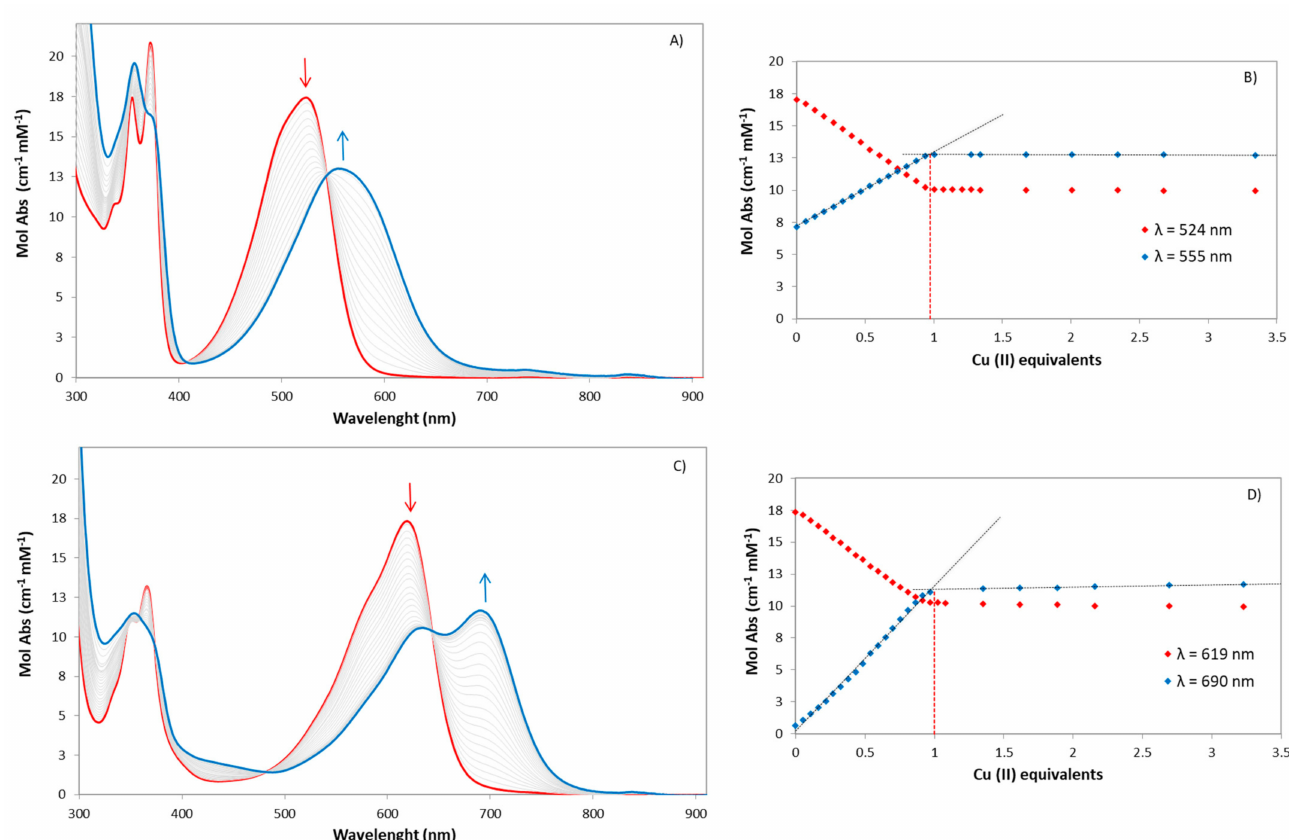
Figure 2. Spectrophotometric titration spectra of 5 µ M ( A ) HP2 and ( C ) PE2 with increasing amounts of Cu(II) in 0.1 M HEPES buffer, pH 7.4, 25 ◦ C, in a cell of 10 cm optical length. Molar absorption profiles at ( B ) 524 (red diamonds) and 555 (blue diamonds) nm for HP2Cu complexation and at ( D ) 619 (red diamonds) and 690 (blue diamonds) nm for PE2Cu